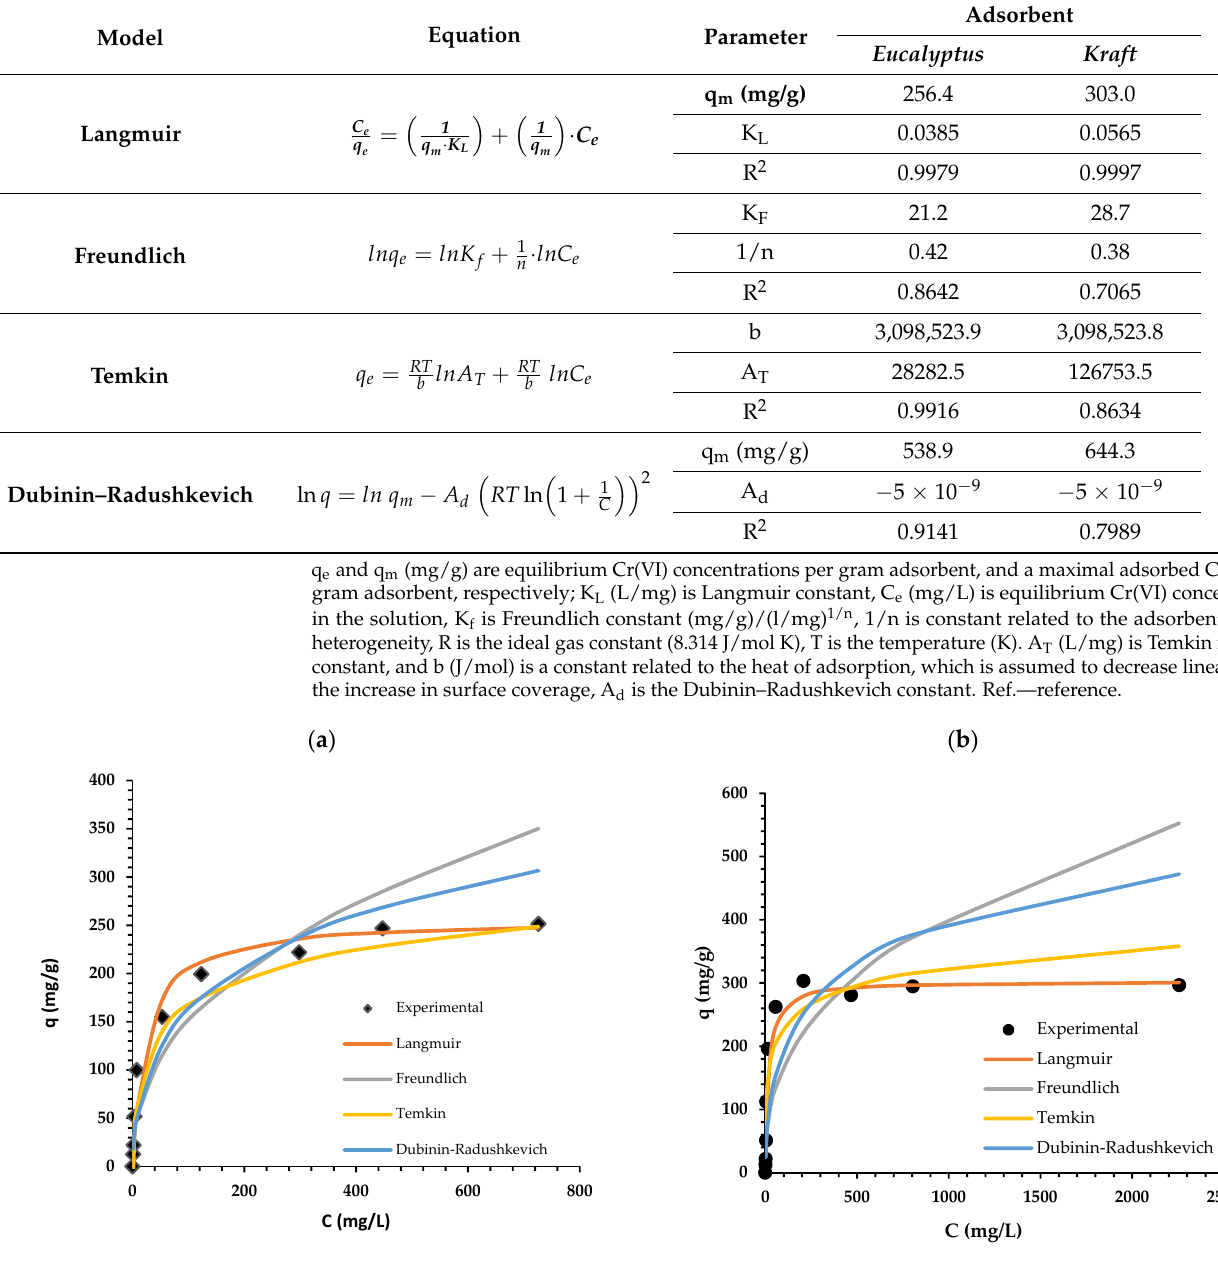
Figure 7. Adsorption isotherms for Cr(VI) adsorption onto eucalypt stump lignin ( a ); and onto kraft lignin ( b ).